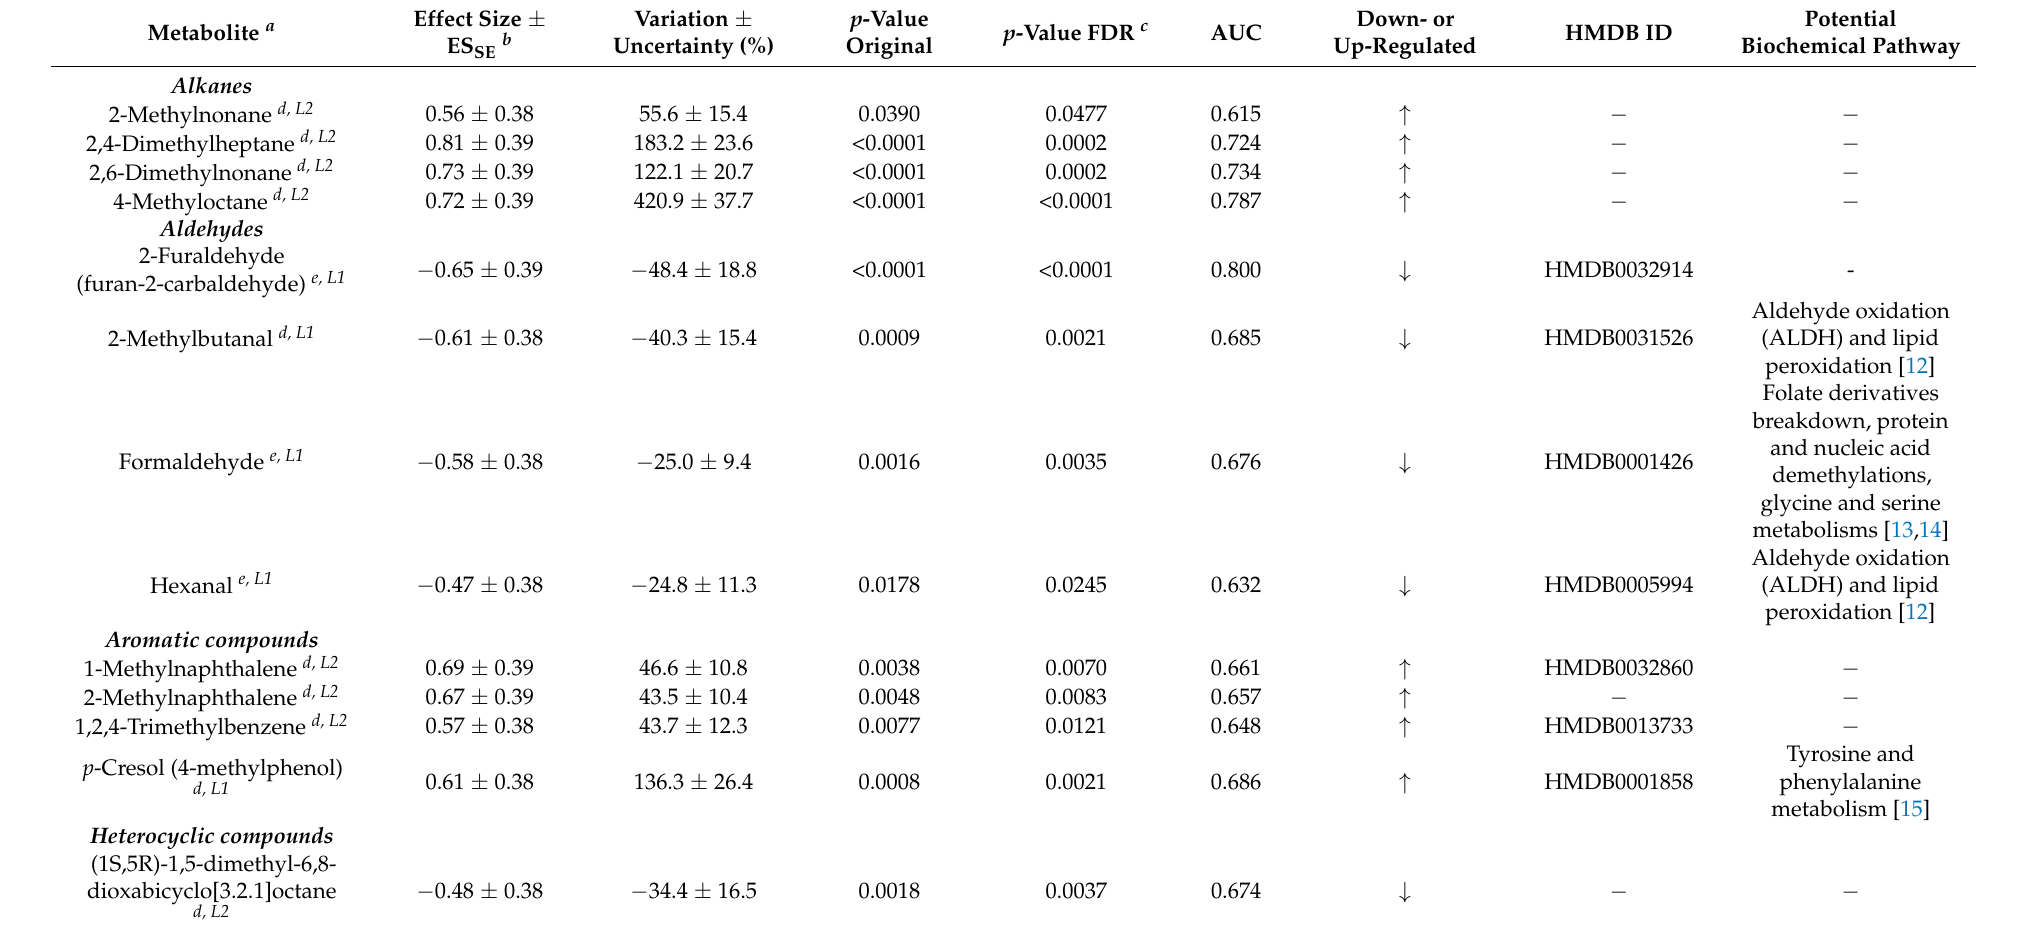
Table 2. List of twenty-three volatile metabolites found altered in urine of BC patients ( n = 53) compared with cancer-free controls ( n =